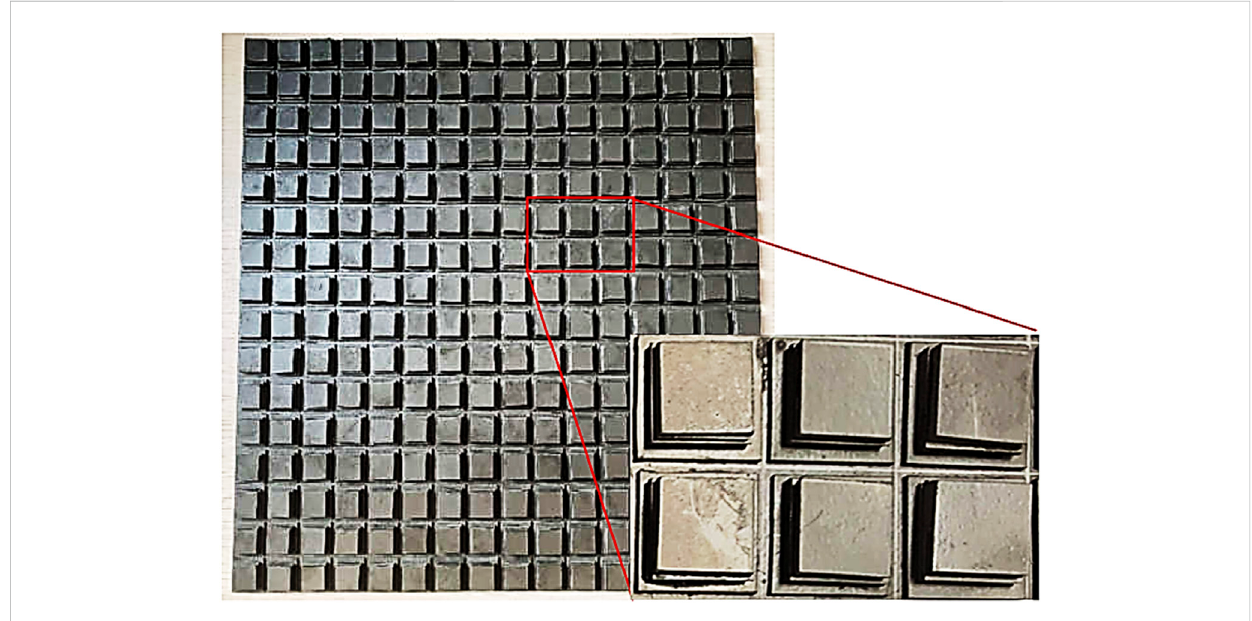
FIGURE 17 Photograph of the fabricated prototype (Ning et al., 2020b).